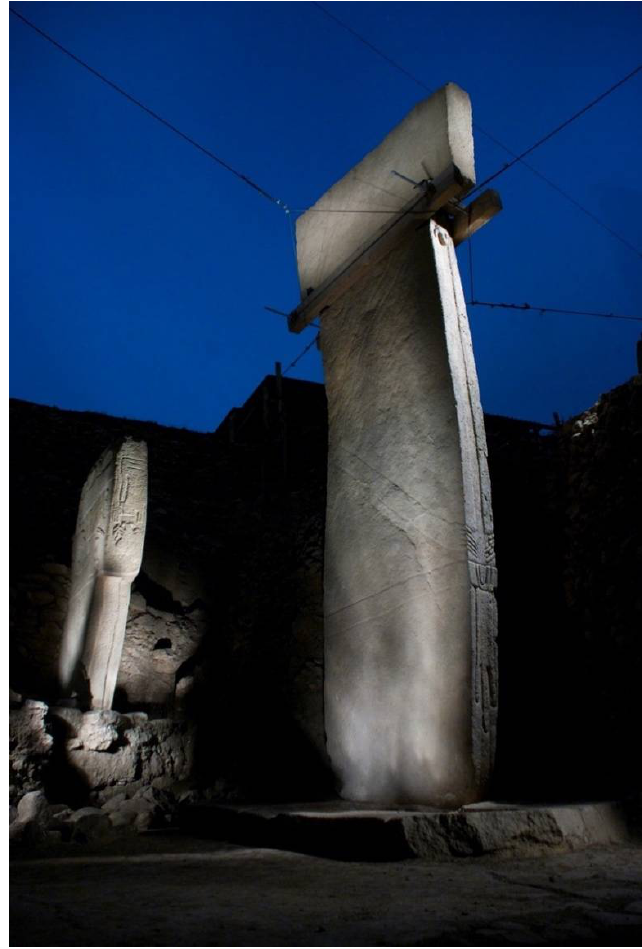
Figure 2. Close-up of the central pillar in Enclosure D (Photo courtesy of Göbekli Tepe Project,